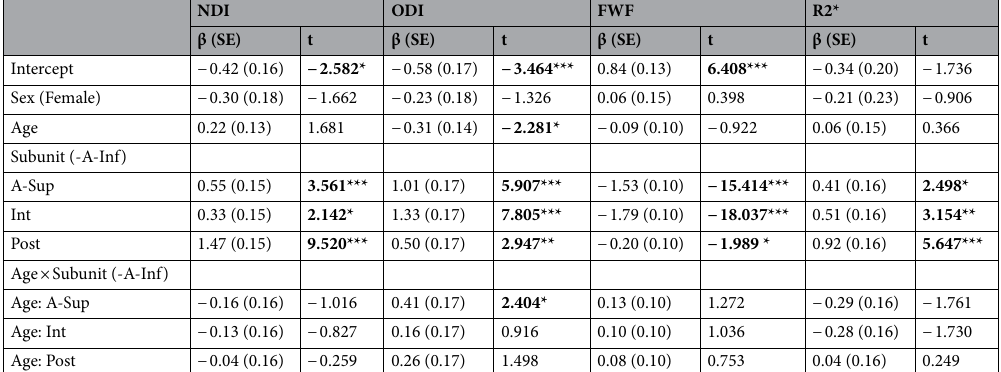
Table 3. Linear mixed effects on hypothalamic microstructure (neurite density index (NDI), orientation dispersion index (ODI), free water fraction (FWF), and effective transverse relaxation rate (R2*)) between subunits (anterior-inferior (A-Inf), anterior–superior (A-sup), intermediate (Int), posterior (Post)) and across age while controlling for sex. *** p < .001, ** p < .01, * p < .05. Significant values are in [bold].